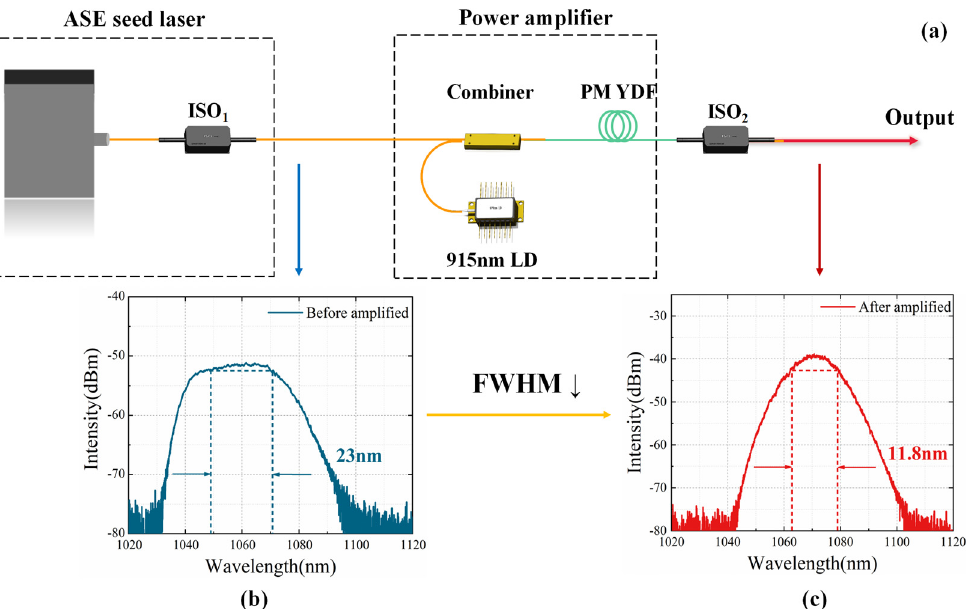
Figure 1. ( a ) ASE fiber source experimental setup. ( b ) The spectrum of ASE source before power amplification. ( c ) The spectrum of ASE source after power amplification. (ISO: isolator; PM YDF: polarization-preserving ytterbium-doped fiber; LD: laser diode).